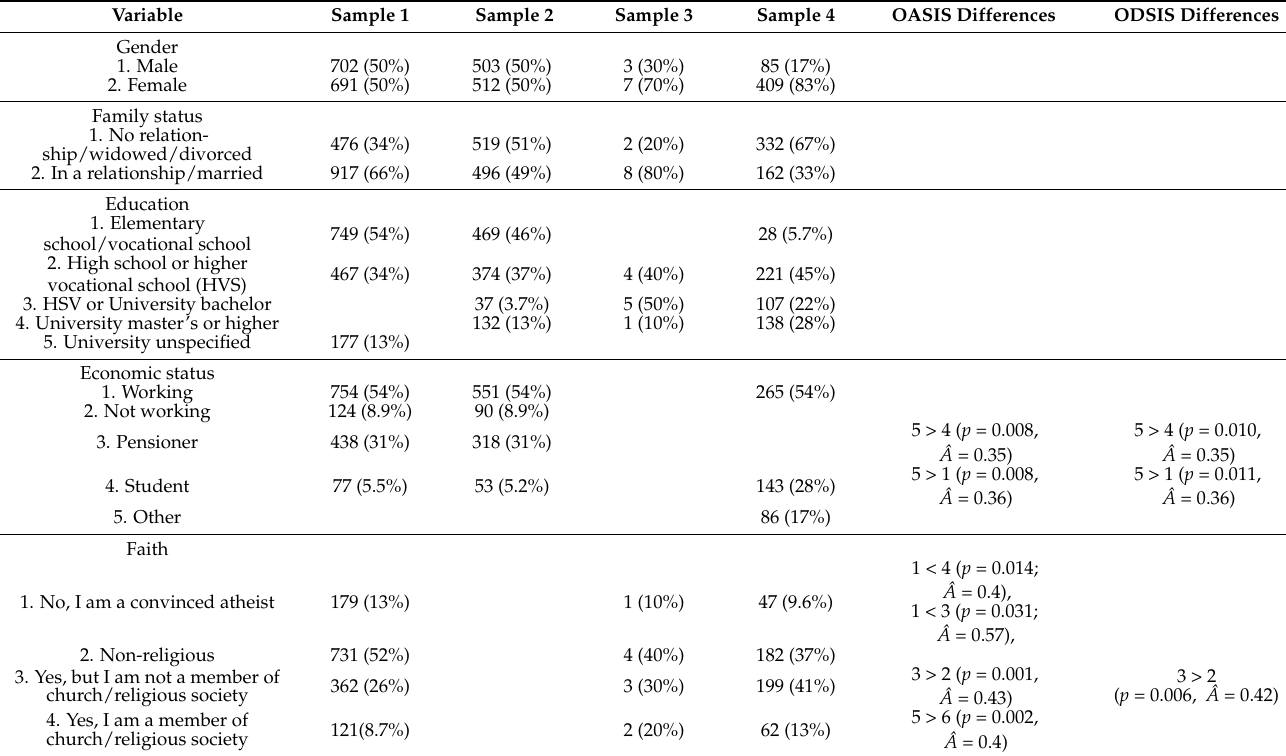
Table 1. Sociodemographic results of the